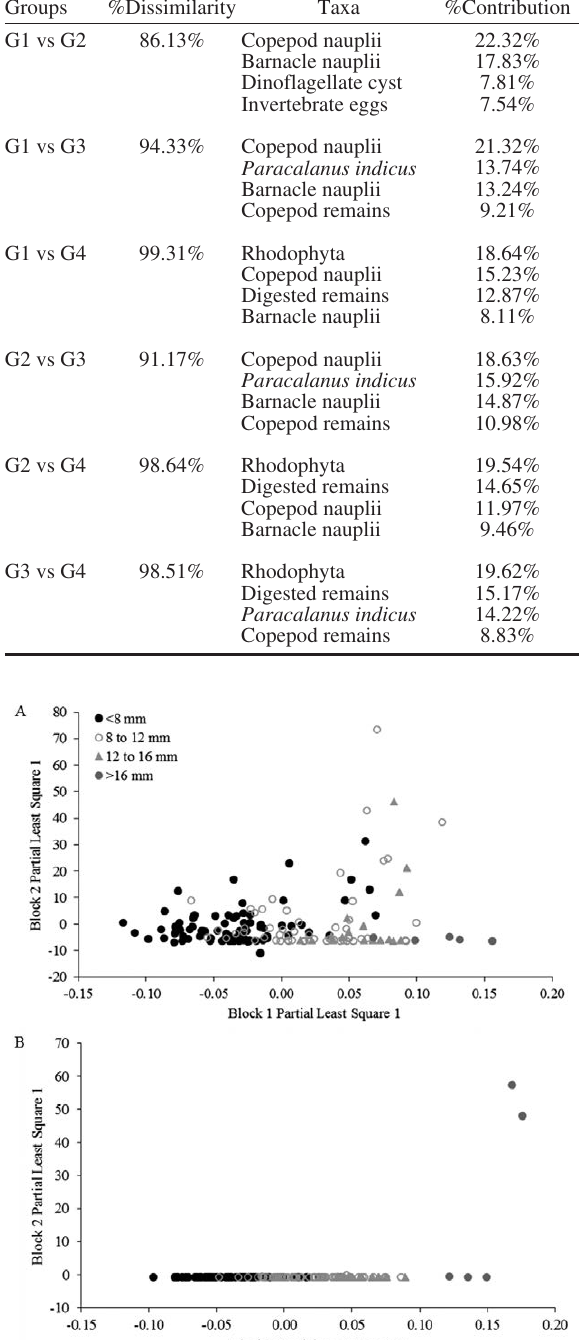
Fig 8. – Partial least square between morphometric changes (Block 1) and diet composition (Block 2) using (A) prey number and, (B) prey